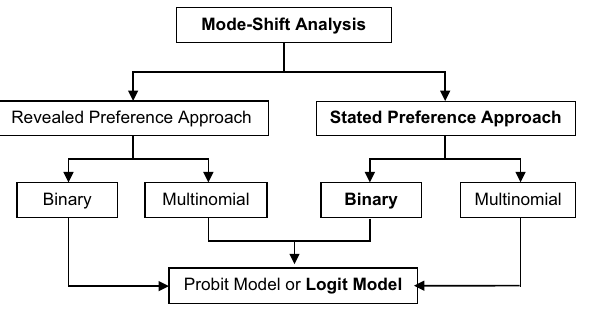
Fig. 2 Modelling method for modal shift